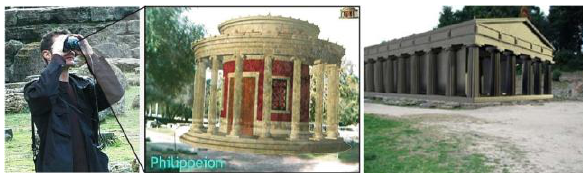
Figure 10. Archeoguide – example of an outdoor AR system (note the virtual temples and additional information that is rendered on top of the real scene, where only ruines are